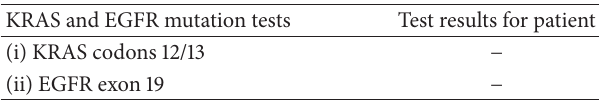
Table 2: Mutation test results of the Asian patient. A positive result for mutation tests indicates mutations in the specified